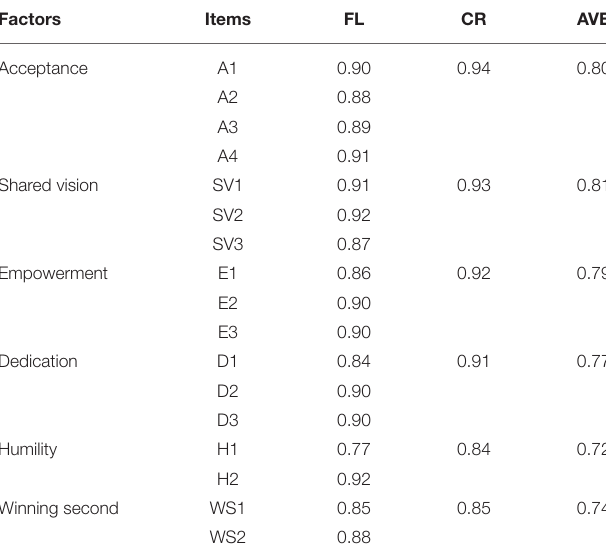
TABLE 4 | Results of confirmatory factor analysis for the coaching servant leadership scale. Factors